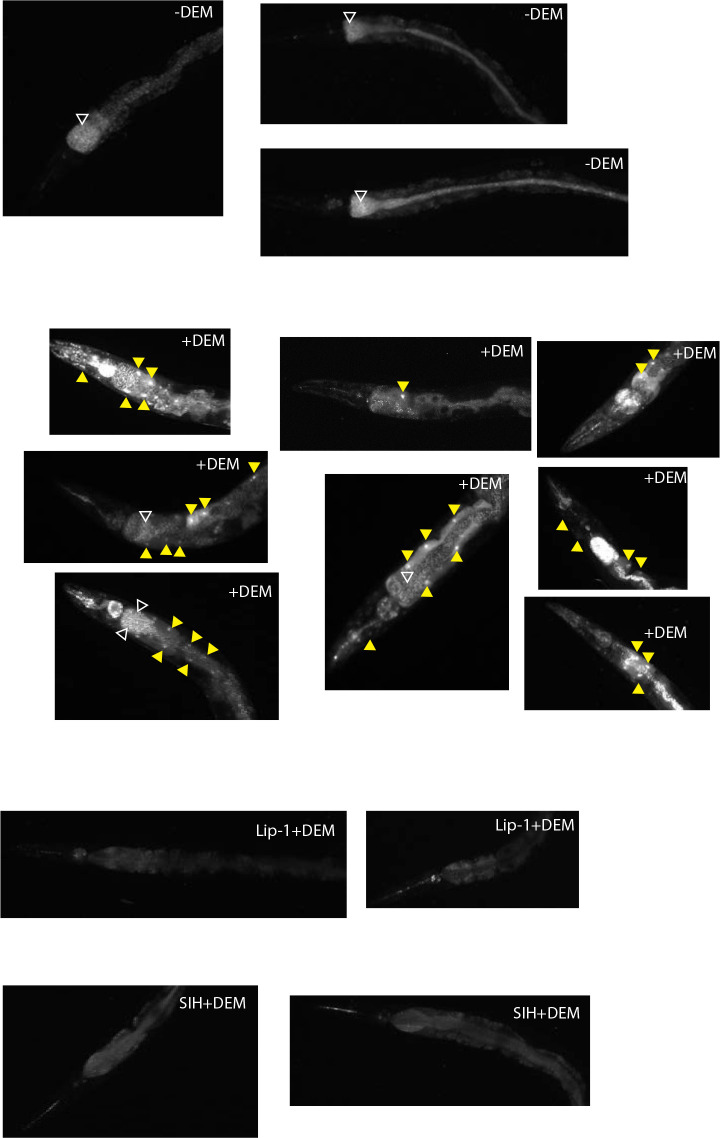
Propidium iodide staining: Cell death observed following treatment with DEM.Representative images are shown in A for DEM-treated animals and B for aging animals. (A) Representative epifluorescence micrographs of dead cell fluorescence (propidium iodide) in animals ± exposure to 10 mM DEM for 24 hr. In animals treated with DEM (+DEM) examples of animals with single through to numerous dying cells (yellow triangles) were observed. Untreated Day 4 adult control animals (-DEM) showed no cell death. Some fine puncta, consistent with labelling of dead bacteria was observed in the intestinal tract (white unfilled triangles). (B) Representative epifluorescence micrographs of dying cell fluorescence (propidium iodide) in aged animals ± treatment with Lip-1 or SIH. In Day 1 control (Ctl) animals no dying cells were observed. In comparison, in Day 6 and Day 8 Ctl animals with dying cells (ranging from a few to many cells) (yellow triangles) were observed. Representative images of age matched animals treated with Lip-1 or SIH without cell death.